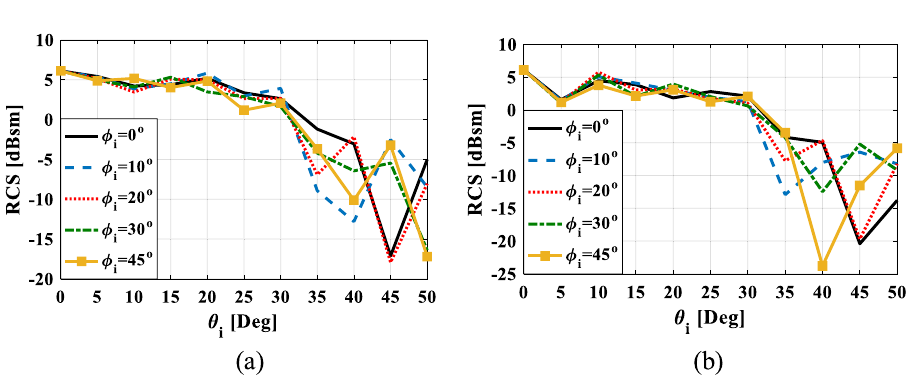
Figure 11. The monostatic RCS diagram of the proposed retroreflector versus elevation incident angle for azimuth angles of φ i = 0 ◦ , 10 ◦ , 20 ◦ , 30 ◦ , 45 ◦ at frequency 9 GHz and for ( a ) TE polarization and ( b ) TM